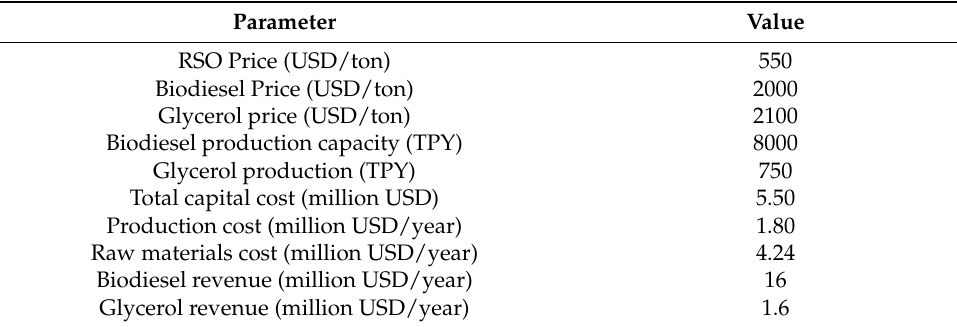
Table 8. Economic analysis result of biodiesel production from